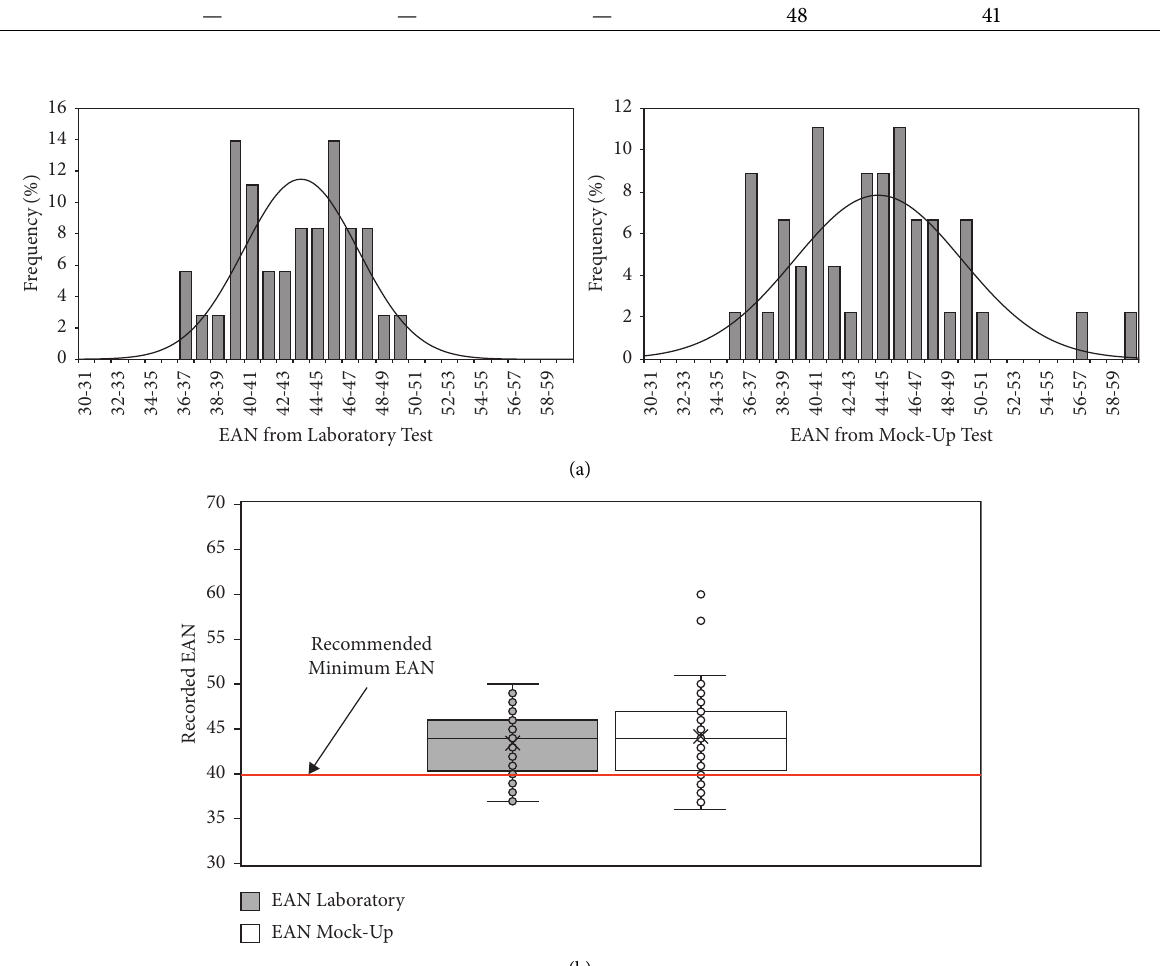
Figure 9: Comparison of exposed aggregate number from laboratory and mock-up test: (a) comparsion of data distribution for EAN in the laboratory and mock-up test; (b) statistical comparison of exposed aggregate number.